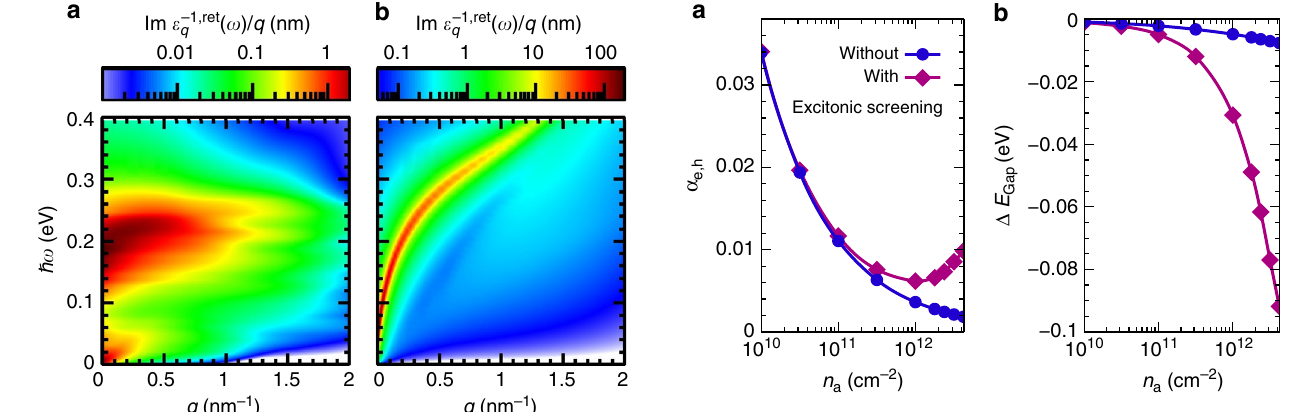
Fig. 7 In fl uence of excitonic screening on the ionization equilibrium. a Degree of ionization with and without excitonic screening as a function of þ n excitation density n a ¼ n a X below the Mott transition in WS 2 on a free SiO 2 substrate at T = 300 K. b Corresponding band-gap renormalization at the K